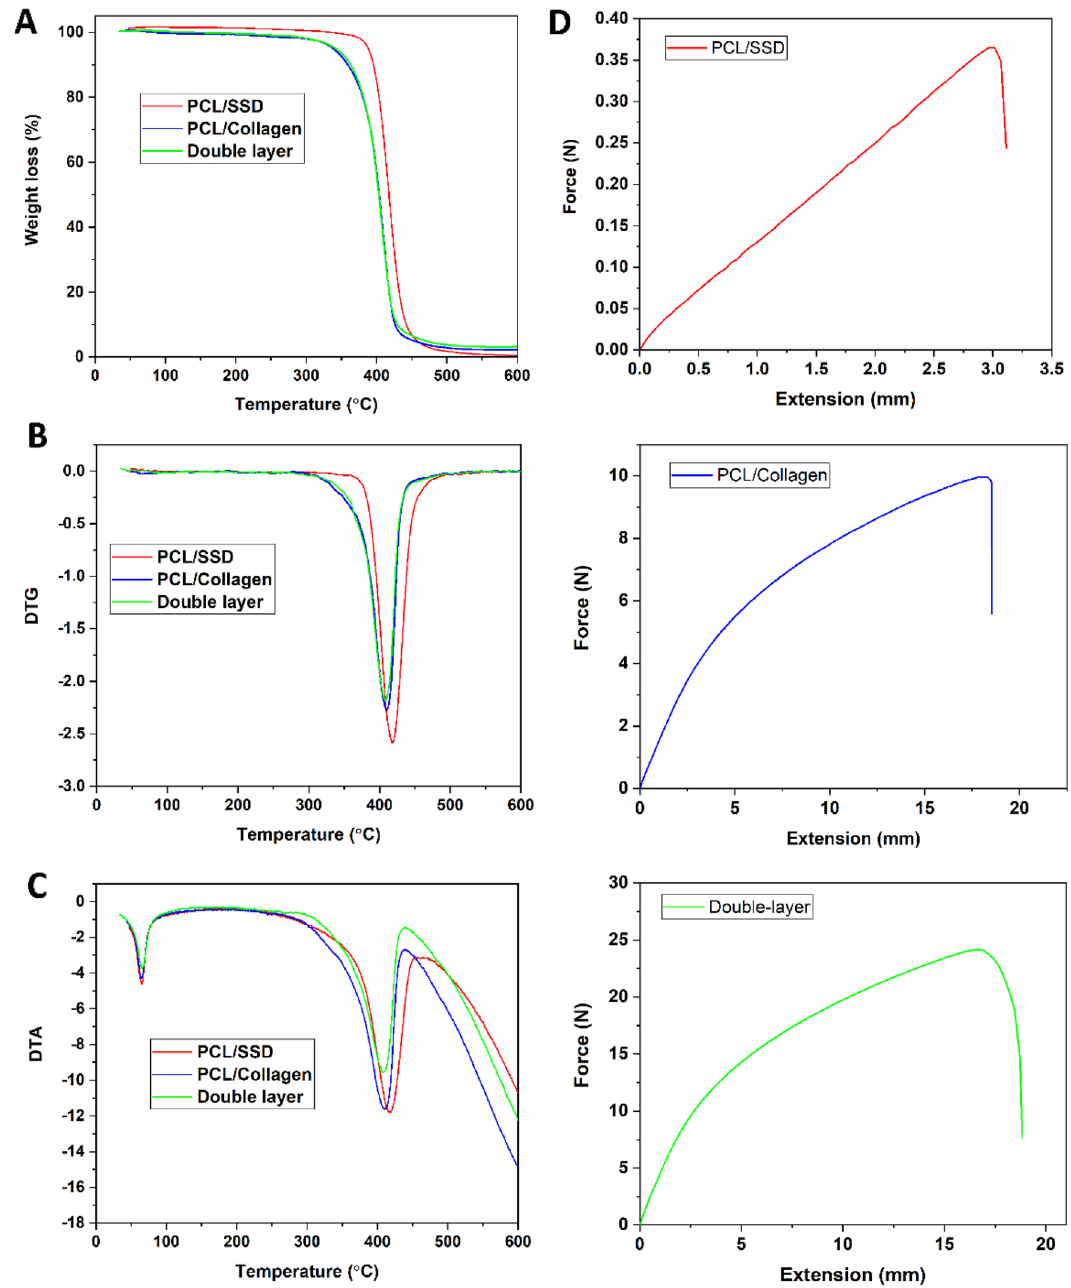
Figure 3. Thermal and mechanical properties of the electrospun nanofibers. ( A ) TGA, ( B ) DTG, and ( C ) DTA graphs of the samples. ( D ) Tensile test of the electrospun